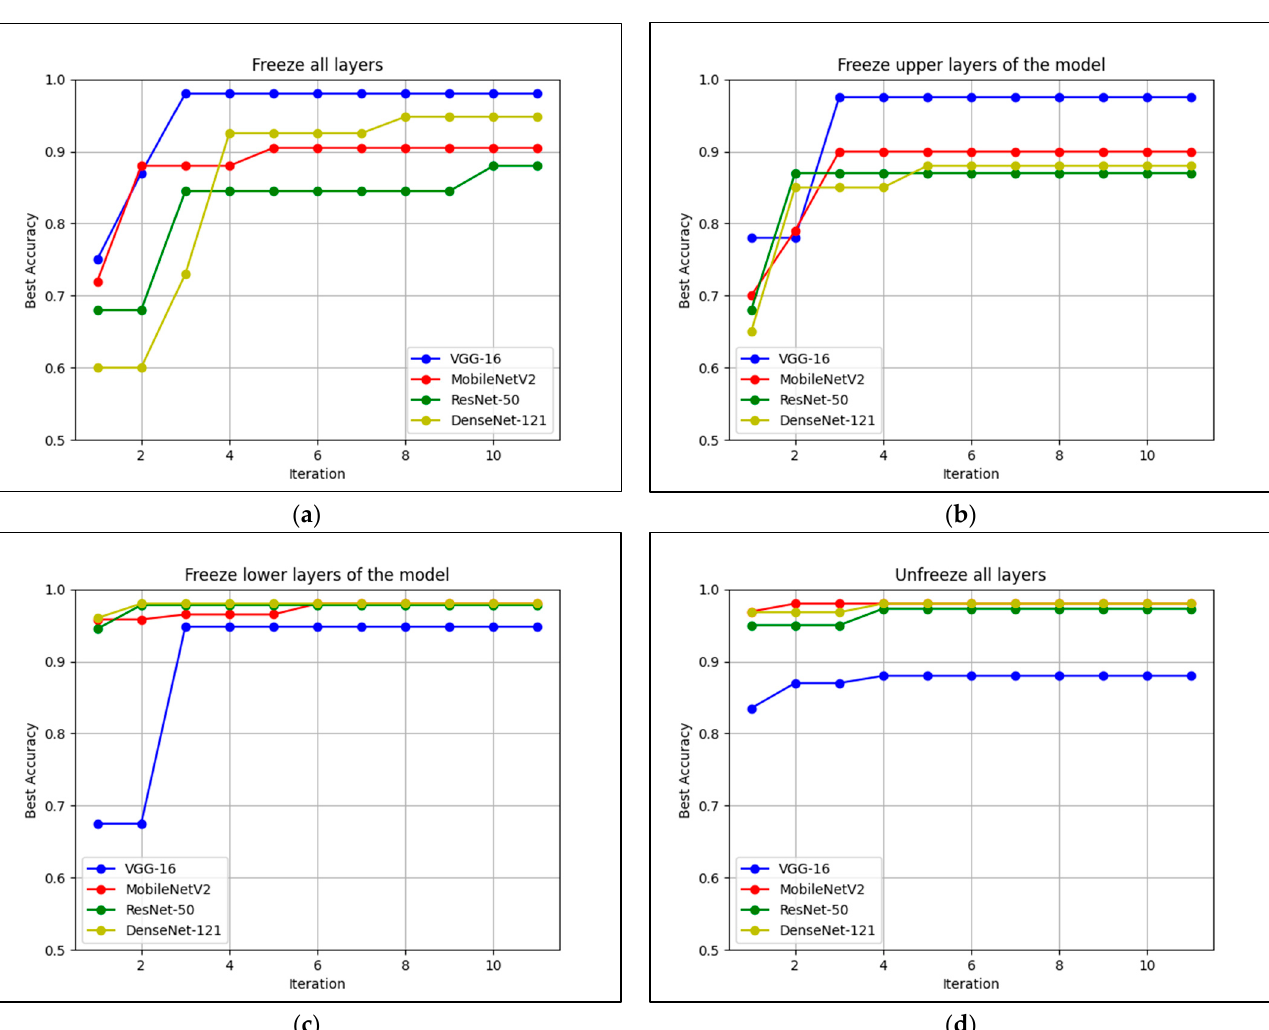
Figure 11. Validation of pre-trained models when some layers were frozen: ( a ) Freeze all layers (the upper and lower layers of the model are FALSE); ( b ) Freeze upper layers of the model (the upper layers are FALSE and the lower layers are TRUE); ( c ) Freeze lower layers of the model (the upper layers are TRUE and the lower layers are FALSE; ( d ) Unfreeze all layers of the model (the upper and lower layers are TRUE.